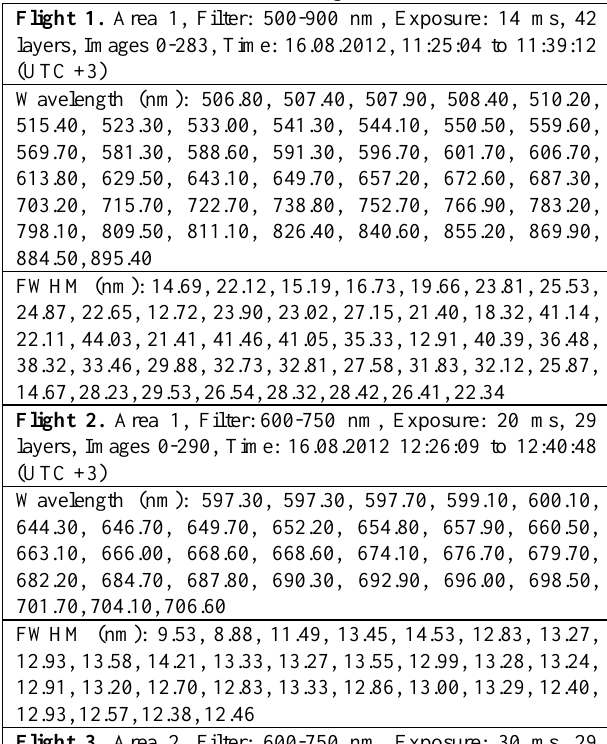
Flight 3. Area 2, Filter: 600-750 nm, Exposure: 30 ms, 29 layers, Images 0-264, Time: 16.08.2012 14:15:43 to 14:30:23